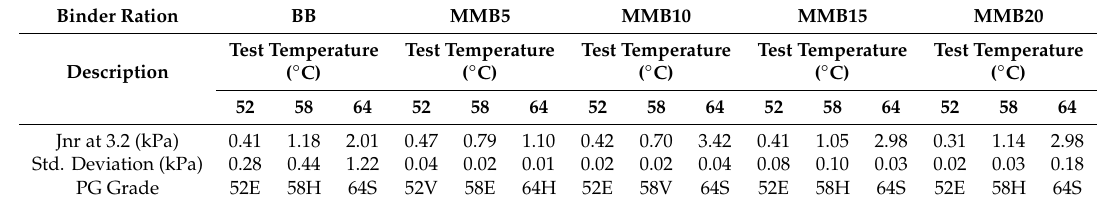
Table 10. Summary of multiple stress creep recover test output.